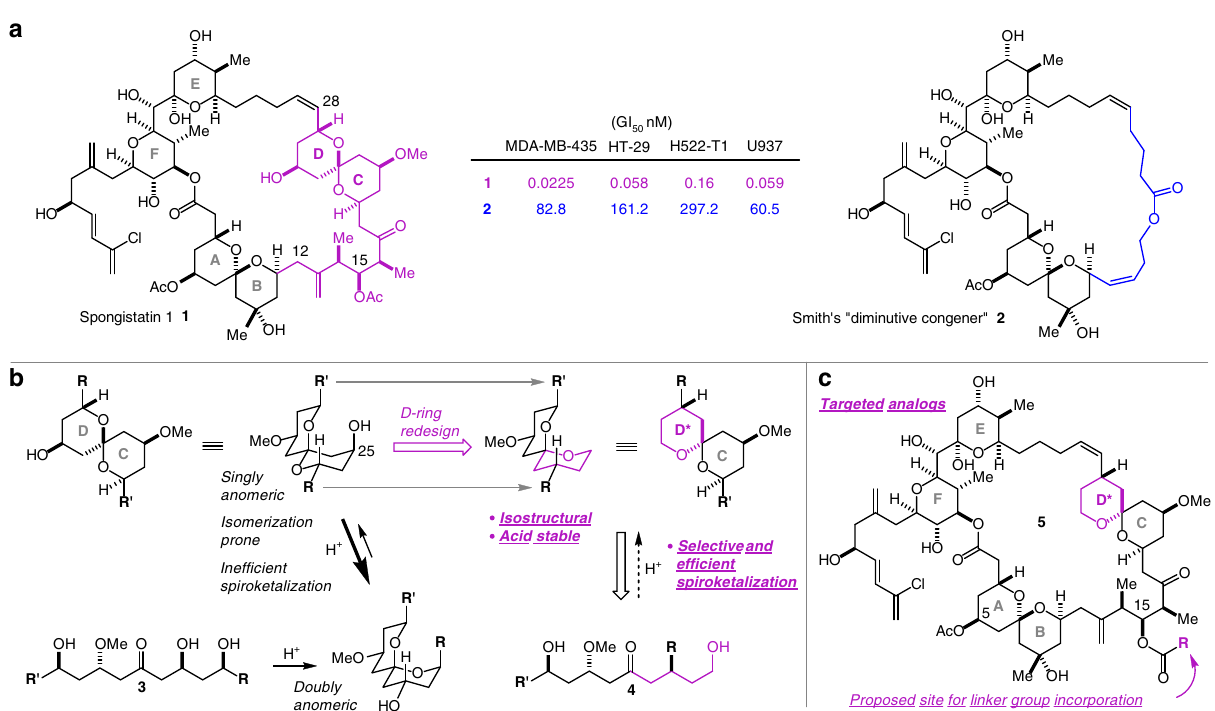
Fig. 1 Spongistatin 1 is an extraordinarily potent anti-mitotic agent whose development is hindered by synthetic inaccessibility. a Smith ’ s simpli fi ed analog 2 retains some signi fi cant potency suggesting that the C(12) – C(18) fragment and the CD spiroketal are not in contact with the receptor in the bound conformation, and that their role is to serve as scaffolding to lock the compound in its active conformation. b Relocation of the D-ring oxygen to the anomeric position and deletion of the C(25) alcohol is proposed to lead to an analog that is isostructural and therefore equipotent with the natural product, stable in the low pH endosomal and lysozomal environments, and signi fi cantly easier to synthesize ef fi ciently by spiroketalization of dihydroxyketone 4 . c The study aims are the development of ef fi cient synthetic access to the spongistatins, synthesis and evaluation of the D-ring modi fi ed analog 5a (R = Me), and validation of the C(15) acyloxy group as a site for linker functional group incorporation without a signi fi cant loss of potency